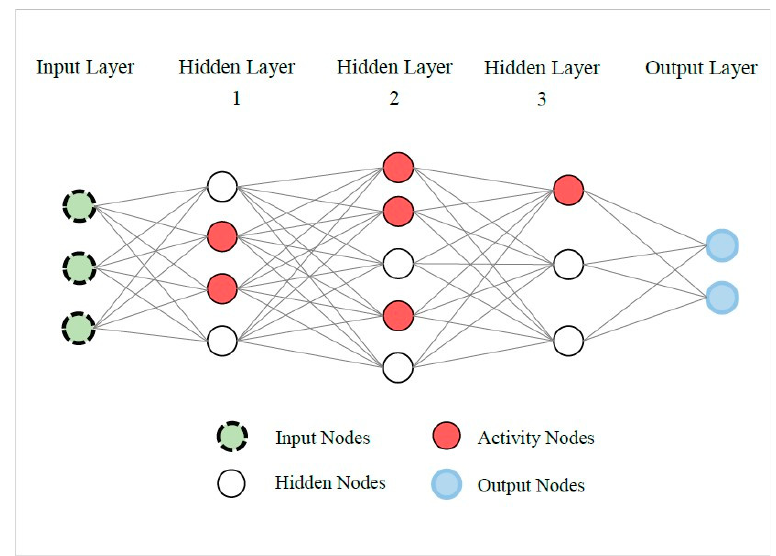
Figure 3. Artificial neural network system.